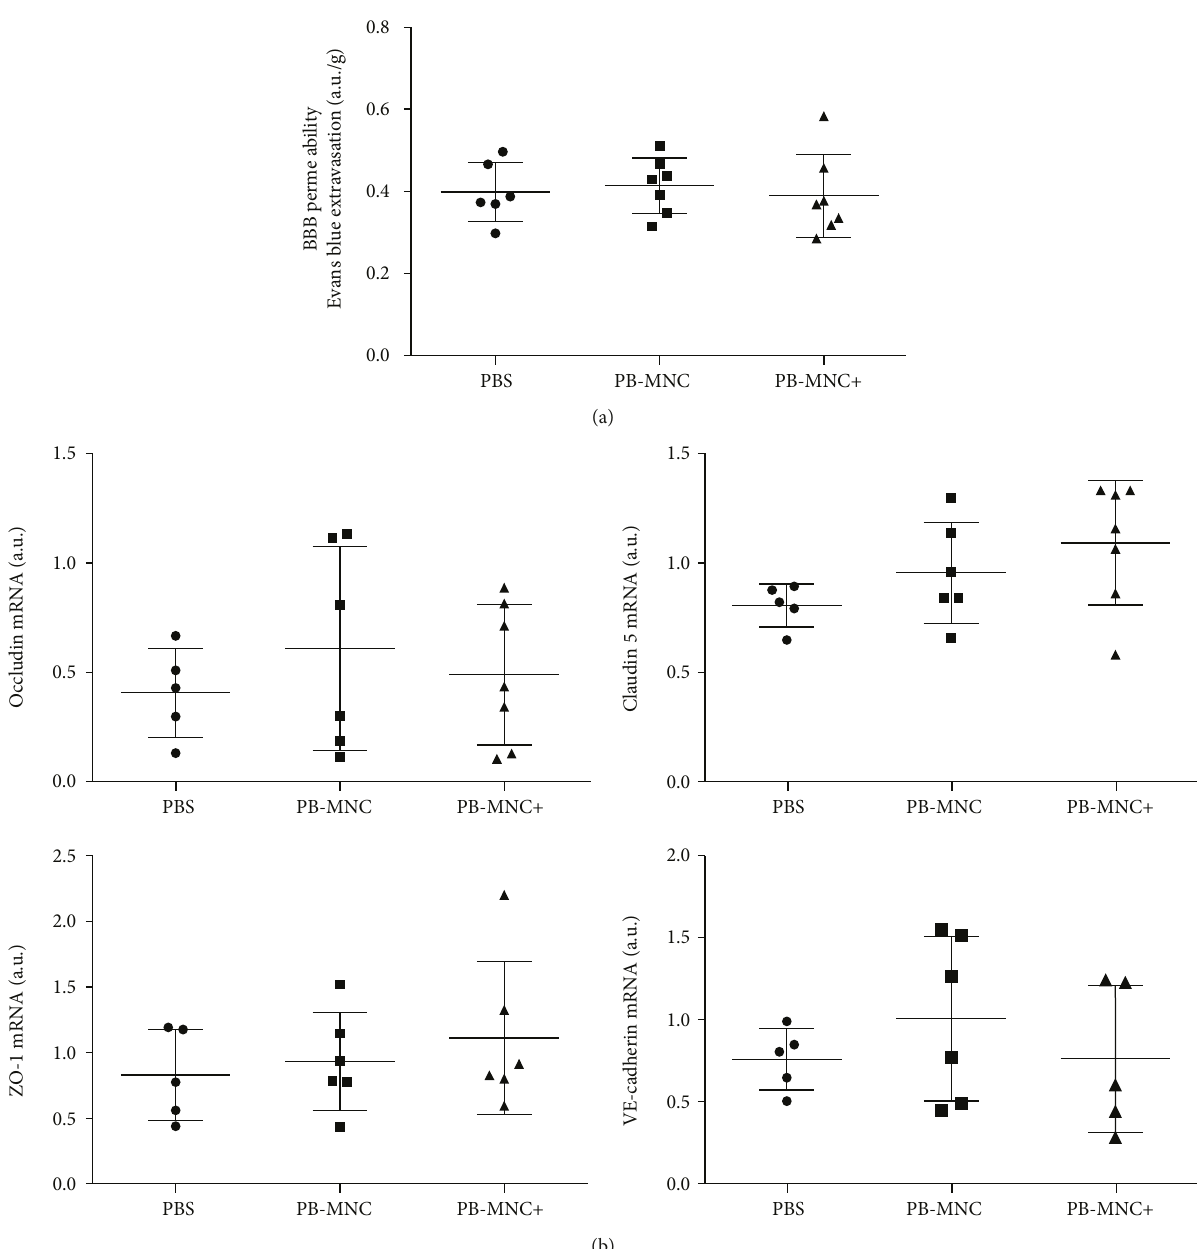
Figure 5: BBB permeability and expression levels of mRNA encoding BBB proteins. (a) PB-MNC, treated or not with ephrin-B2, compared to PBS, did not modify Evans blue extravasation ( N = 6 – 7 ). (b) There was no signi fi cant di ff erence in occludin, claudin 5, ZO-1, and VE-cadherin mRNA expression between the three groups of mice ( N = 5 – 7 ). Data are presented as mean ±